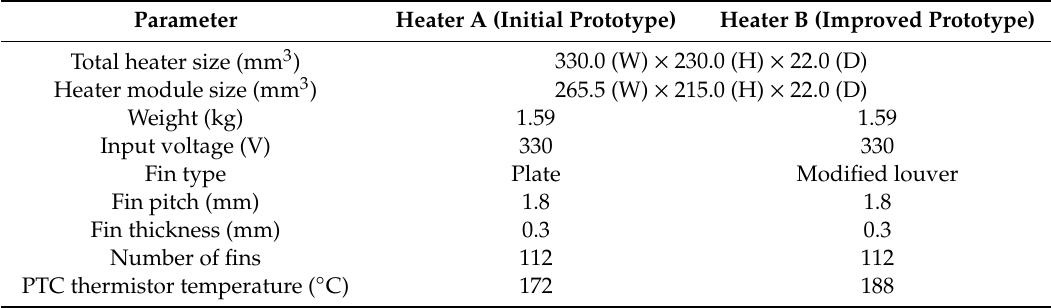
Table 1. Specification of positive temperature coe ffi cient (PTC) heaters A and